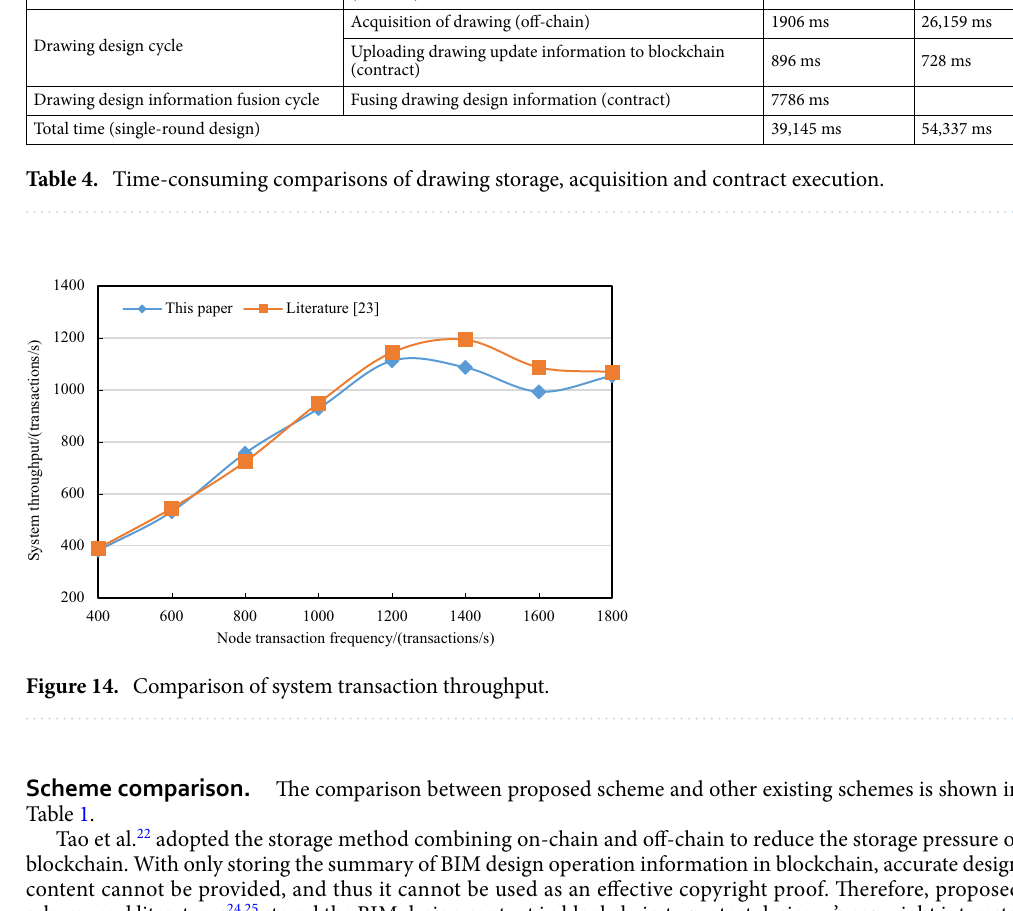
Table 1. Tao et al. 22 adopted the storage method combining on-chain and off-chain to reduce the storage pressure of